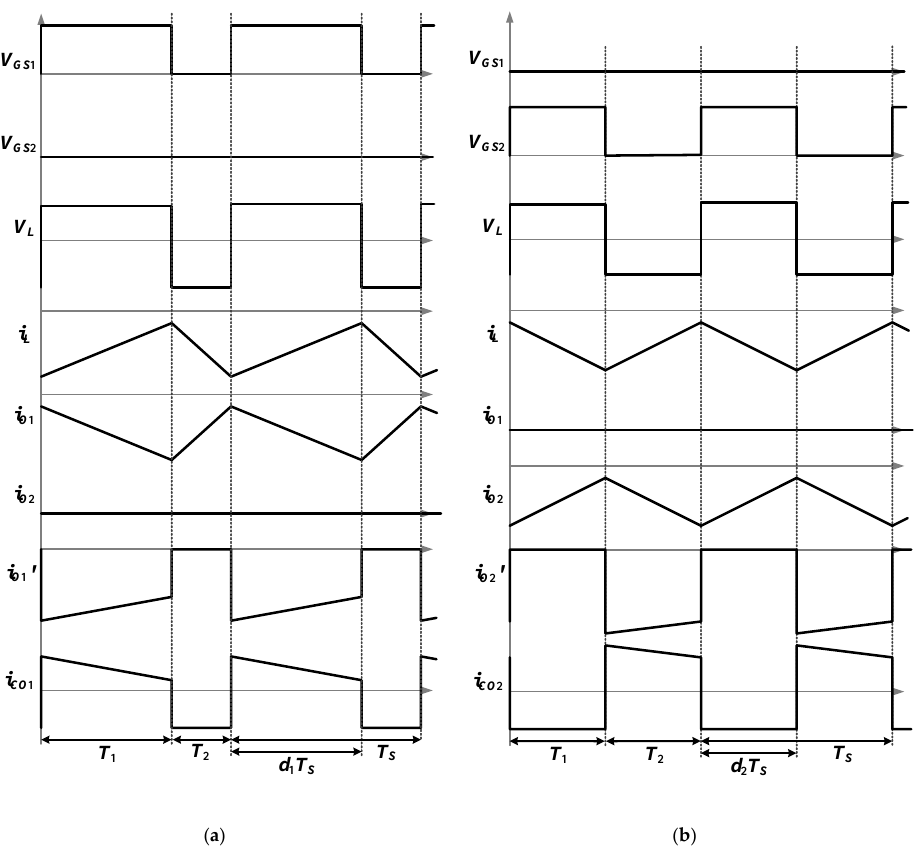
Figure 8. Theoretical waveforms of ( a ) The charging scenario A; ( b ) The charging scenario B.